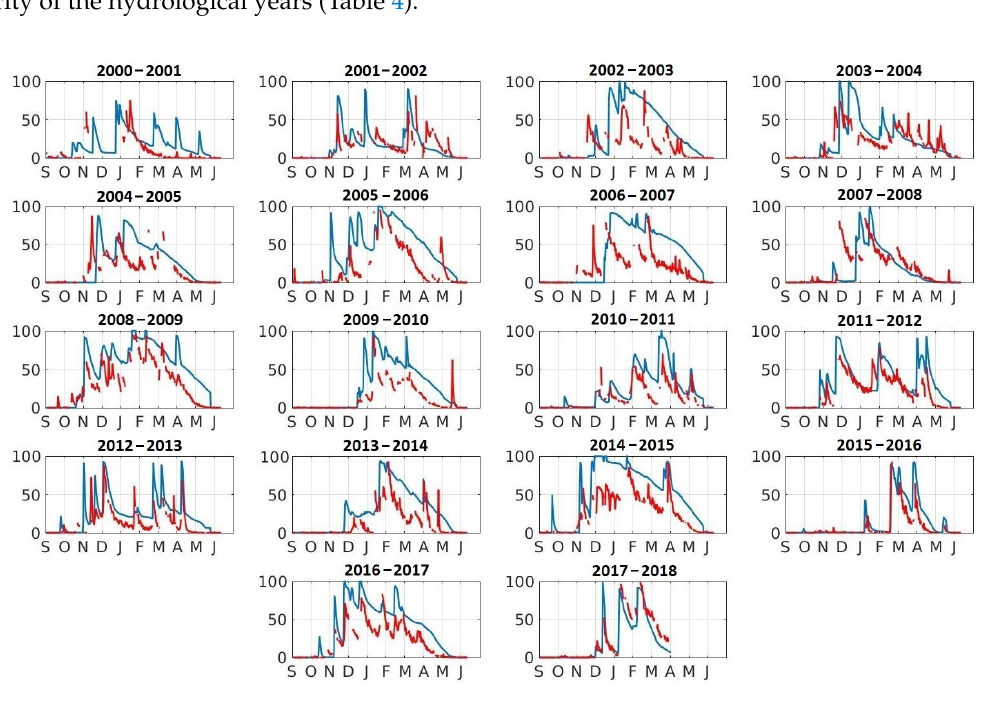
Figure 6. Time series of the simulated ( blue ) and observed ( red ) snow cover fraction of the Ourika catchment. Table 4. R 2 between the simulated and observed snow cover area (SCA) and discharge ( Q ) in the Ourika catchment for every hydrological year of the study period. The R 2 was computed at the daily time step from 1 September–31 May for SCA and at the monthly time step from January–May for Q (NA: no measurements available for this